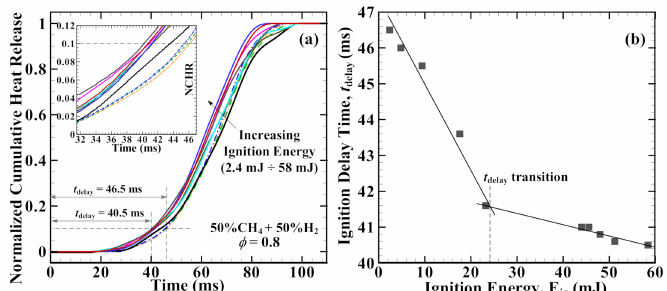
Figure 7. Effect of ignition energy on the ignition delay time ( t delay ): ( a ) where E ig is varied in a range of 2.4 mJ–58 mJ using a car ignition coil. The inset is a close-look at very beginning of NCHR in which t delay values are determined. ( b ) The value of t delay (solid symbols) are plotted against E ig , showing a t delay transition at E ig, critical ≈ 24 mJ.